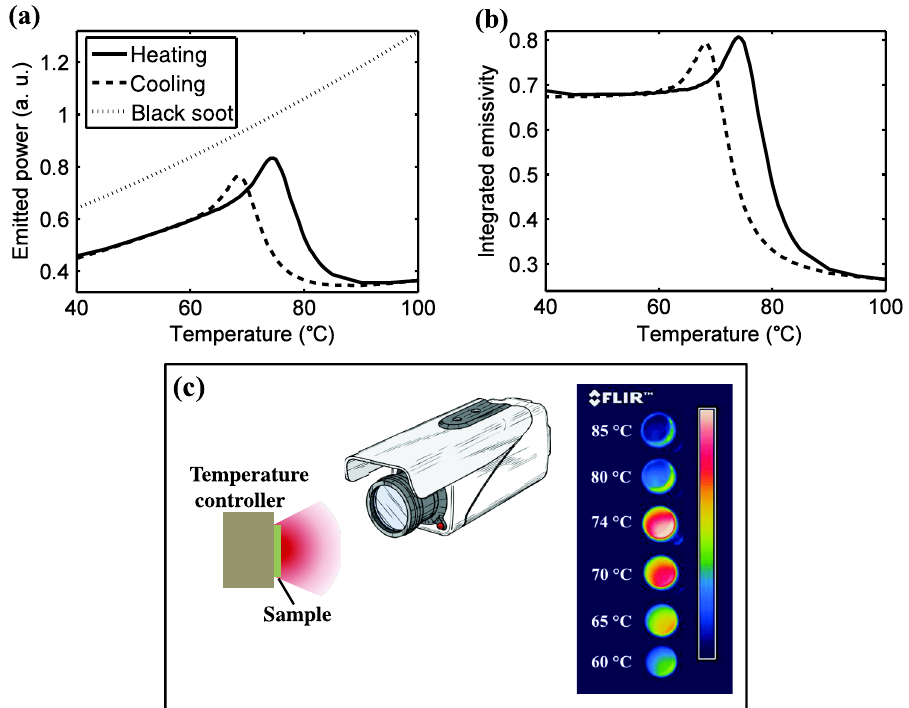
FIG. 3. (a) Emitted power of the VO 2 -sapphire sample integrated over the 8- to 14 - (cid:1) m atmospheric transmission window for heating (solid line) and cooling (dashed line), compared to the emitted power from black soot. (b) The integrated emissivity of the 14 - (cid:1) m wavelength range. (c). Infrared camera images of the sample (diameter ¼ 1 cm ) for VO 2 -sapphire sample over the 8- to increasing